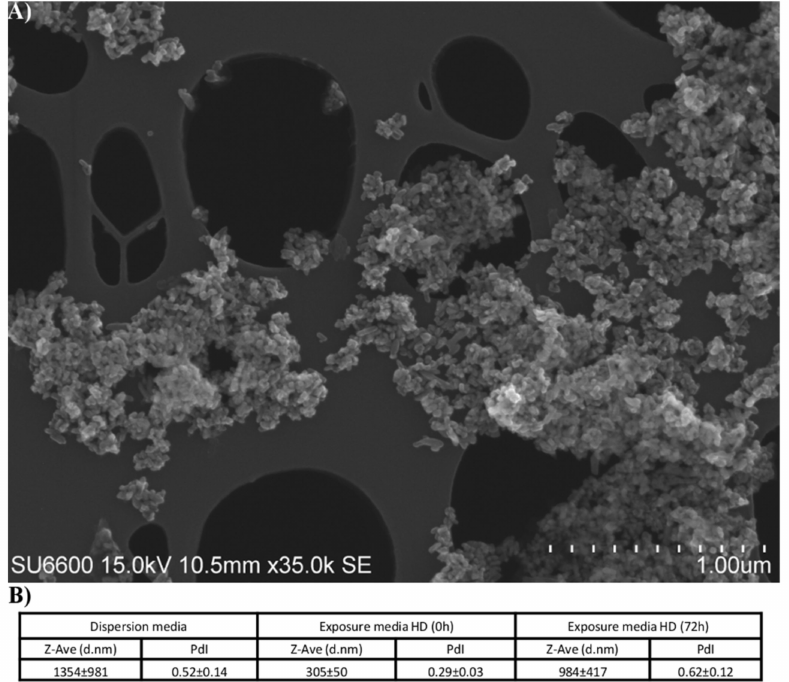
Figure 1. Characterization of TiO 2 particles. ( A ) Representative SEM image of TiO 2 particles in dispersion media. ( B ) Hydrodynamic diameter measurements were conducted in dispersion media, and in cell culture media at time of exposure (0 h) and after 72 h. Abbreviations: Z-Ave: Z-average; d.nm: diameter in nm; PdI: polydispersity index.